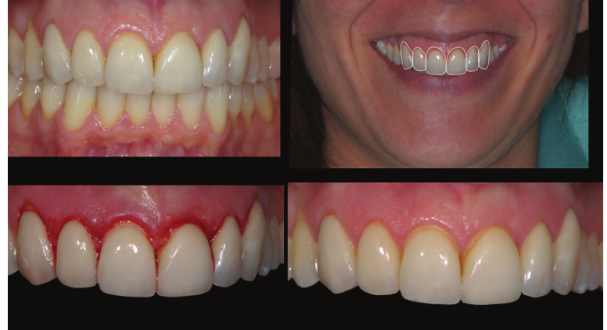
Figure 5: Case 2 (Bilayered Lithium Disilicate Veneer Replace- ment). A female patient asked for the replacement of 6 porcelain laminate veneers with discolored and fractured margins. After the study of the case, done with the aid of digital software programs, a crown lengthening procedure was performed.